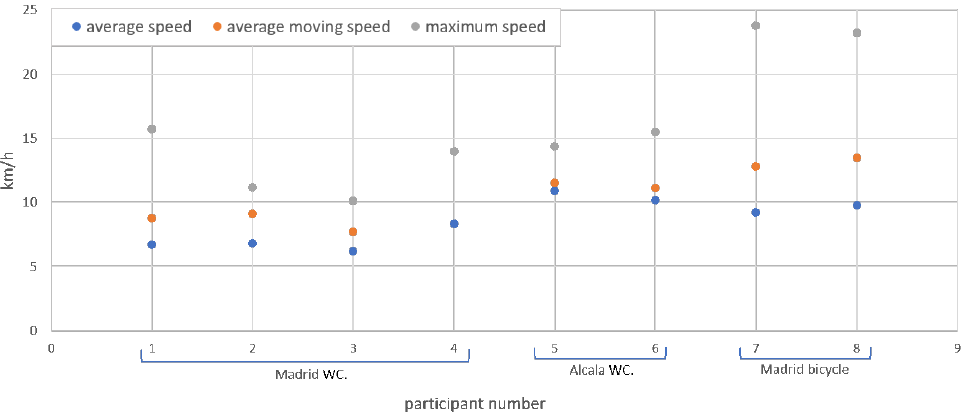
Figure 7. The average speed, average moving speed, and maximum speed for all cyclists and wheelchair users who participated in the